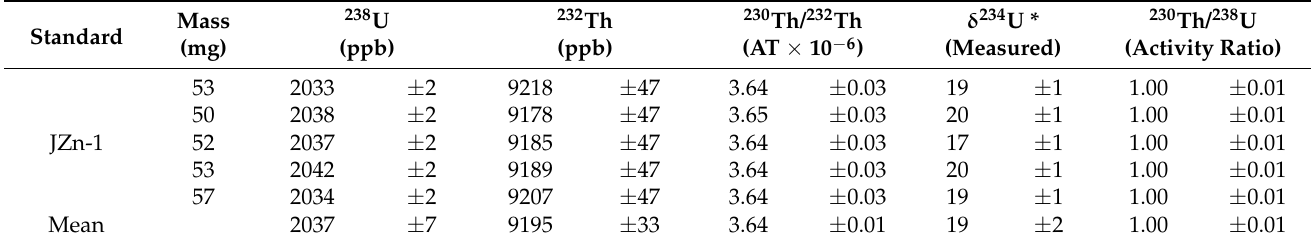
Table 5. U-Th contents and isotopic ratios for sulfide standard JZn- 1 (±2σ, absolute value). Mass